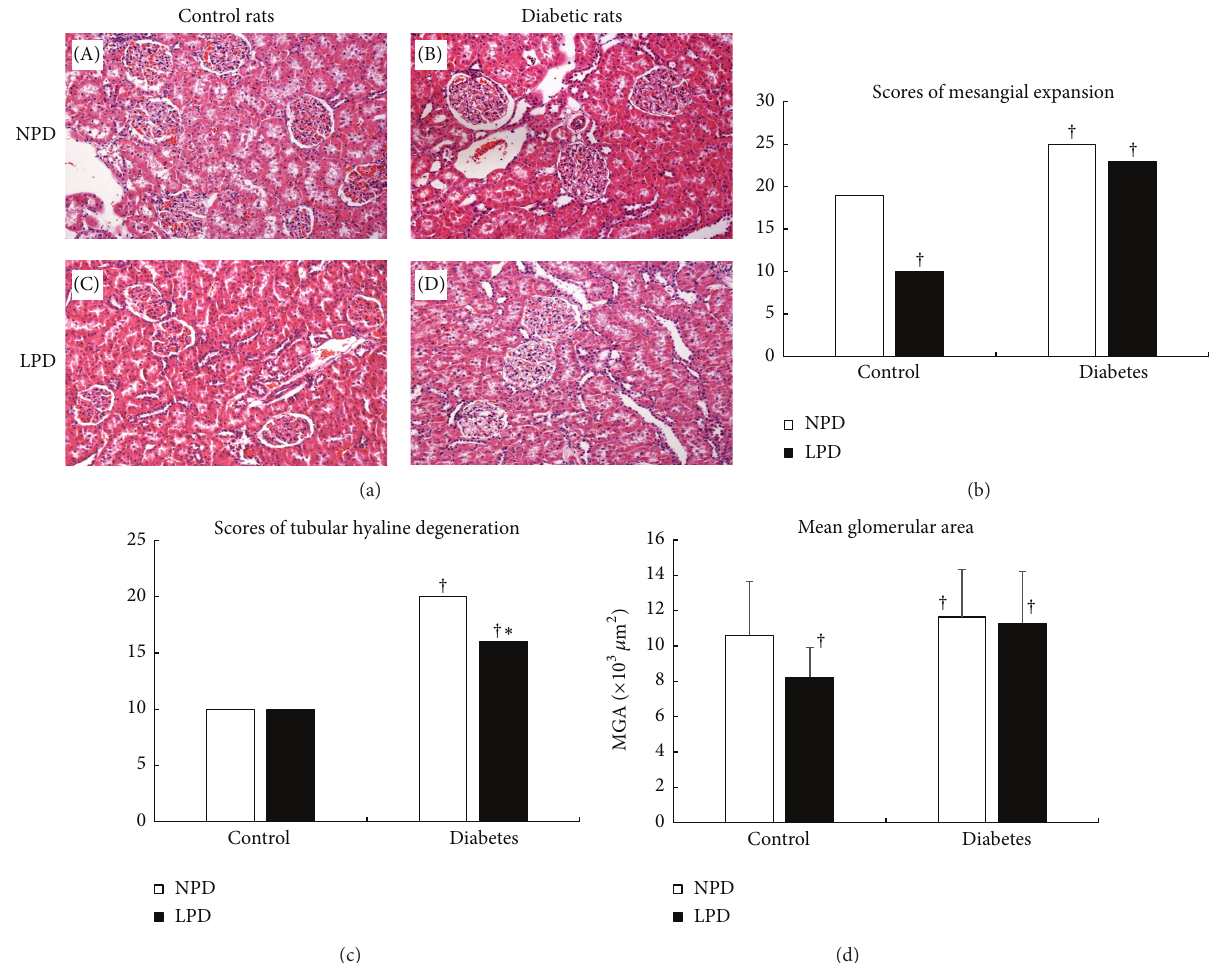
Figure 5: Glomerular and tubulointerstitial alterations in diabetic and control rats. (a) Representative glomerular and tubular structures in the Hematoxylin and Eosin staining. Compared with control rats ((A), (C)), diabetic rats ((B), (D)) showed more severe mesangial expansion and tubular hyaline degeneration. LPD significantly improved mesangial expansion (C) in control rats instead of diabetic rats (D), while it ameliorated the degree of tubular hyaline degeneration in diabetic rats (D) and had no same effects in control rats (C). (b) Quantitative scores of mesangial expansion. (c) Quantitative scores of tubular hyaline degeneration. (d) Alterations of mean glomerular area (MGA) among different groups. LPD reduced MGA in control rats but not in diabetic rats. In (b), (c), and (d), NPD is shown as ( ◻ ) and LPD is shown as ( ◼ ). Data in (d) were expressed as mean ± SD. † 𝑃 < 0.05 compared with C-NPD group. ∗ 𝑃 < 0.05 was compared with D-NPD